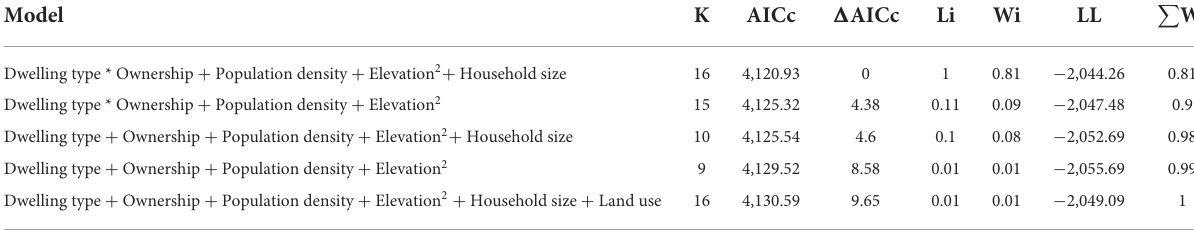
TABLE 3 Reduced candidate model list of models < 10 1 AICc ranked using Akaike Information Criterion (AIC) to explain the number of dogs owned per household of residents of Costa Rica.